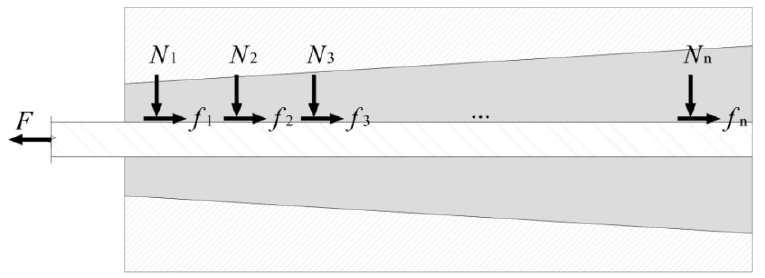
Figure 4. Stress analysis for oblique cone.